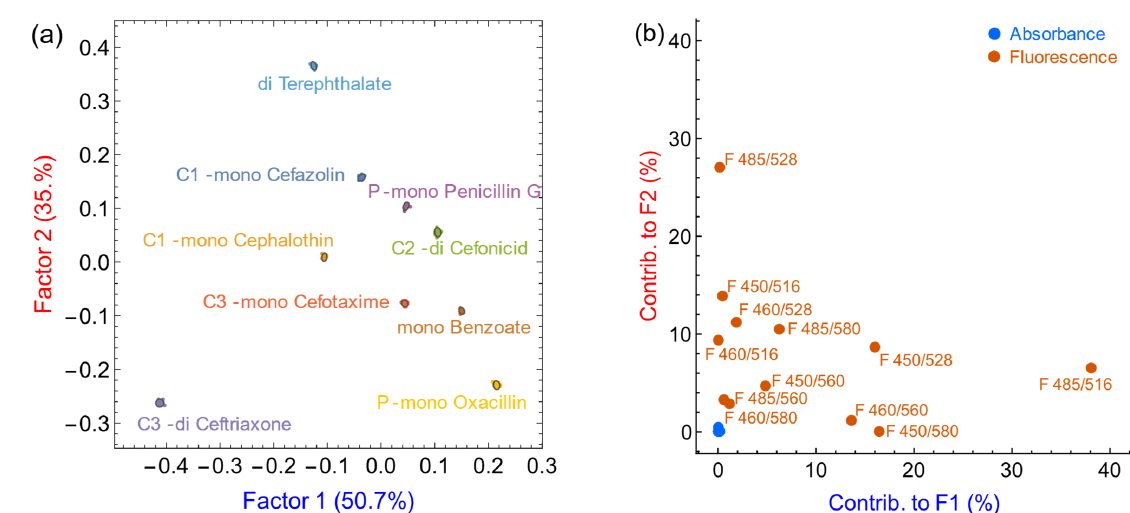
Figure 6. LDA results for qualitative discrimination of nine analytes (two penicillins, five cephalosporins and two reference carboxylates) using [calcein•PAMAM] sensor and hydrolytic sample pre-treatment. ( a ) Scores plot; ( b ) loadings plot. Abs: absorbance, F: fluorescence emission λ ex / λ em ). Analyte solutions were prepared at pH 10 and then brought back to pH 7.4 for β -lactam ring hydrolysis. The same set of raw measurements was used as in Figure 5, but measurements of absorbance in the UV range and dye clusters were removed to improve analyte separation. [calcein] = 6.36 μ M, [PAMAM G5] = 2.13 μ M, [analytes] = 5.0 mM. Performed in 50 mM aqueous HEPES buffer, T = 25 °C.